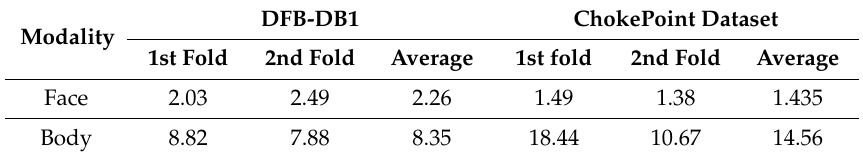
Table 7. Comparisons of EERs by face and human recognition using body (unit: %).